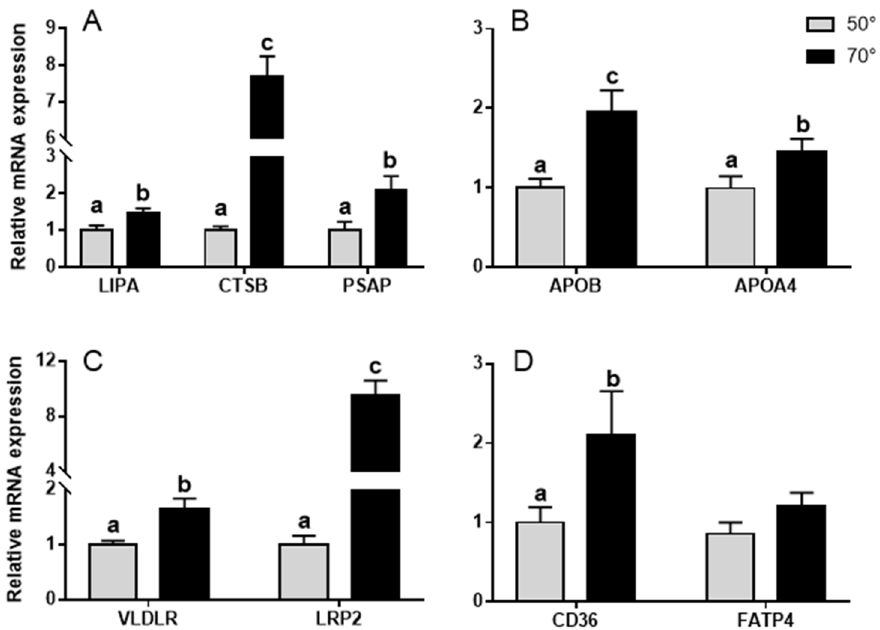
Figure 4. mRNA levels of genes relative to β -actin, ( A ) LIPA, CTSB, and PSAP, ( B ) APOB and APOA4, ( C ) VLDLR and LRP2, and ( D ) CD36 and FATP4 of goose embryo yolk sac membranes between the 50 ° and 70 ° turning angle groups. Data are shown as mean values ± standard error of the mean. Different letters above the bars denote significant differences between the different treatment groups (a,b: p < 0.05; a,c: p < 0.01).